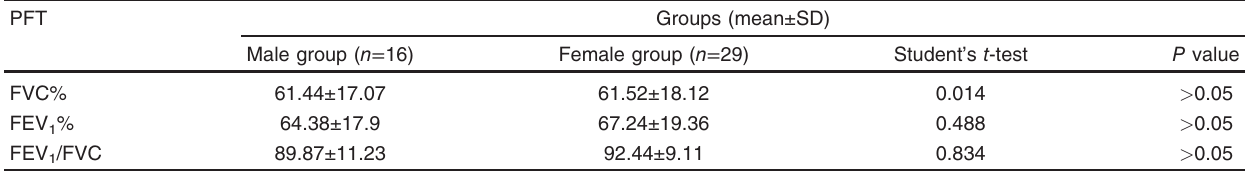
Table 4 Differences between males and females regarding pulmonary functions in group A PFT